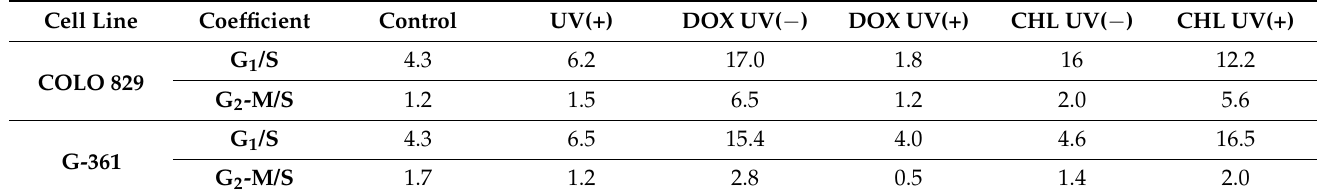
Table 2. The analysis of the cell cycle presented as a relative ratio of G 1 /S and G 2 -M/S for COLO 829 and G-361 melanoma cells treated with DOX and CHL and exposed to UVA